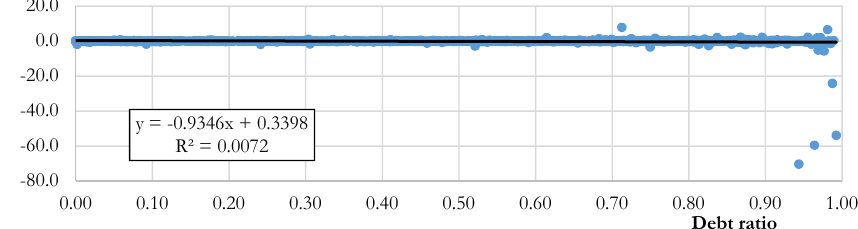
Fig. 6 – Relationship of ROE and debt ratio in the business sector G - Wholesale and retail trade; repair of motor vehicles and motorcycles. Source: Own investigation.